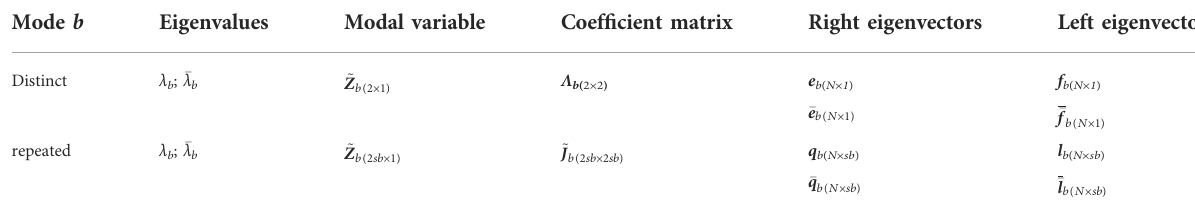
TABLE 1 Information corresponding to mode b